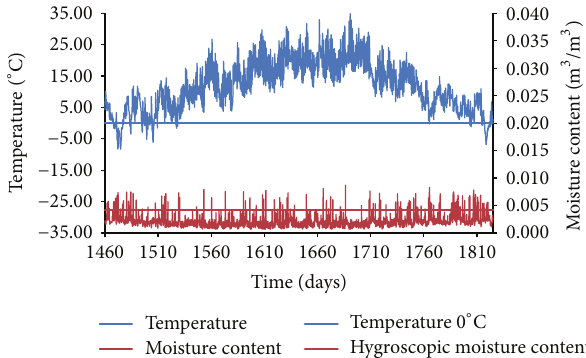
Figure 10: Relative humidity profiles, Holeˇsov’s climatic conditions, July 15, 3:00 p.m.